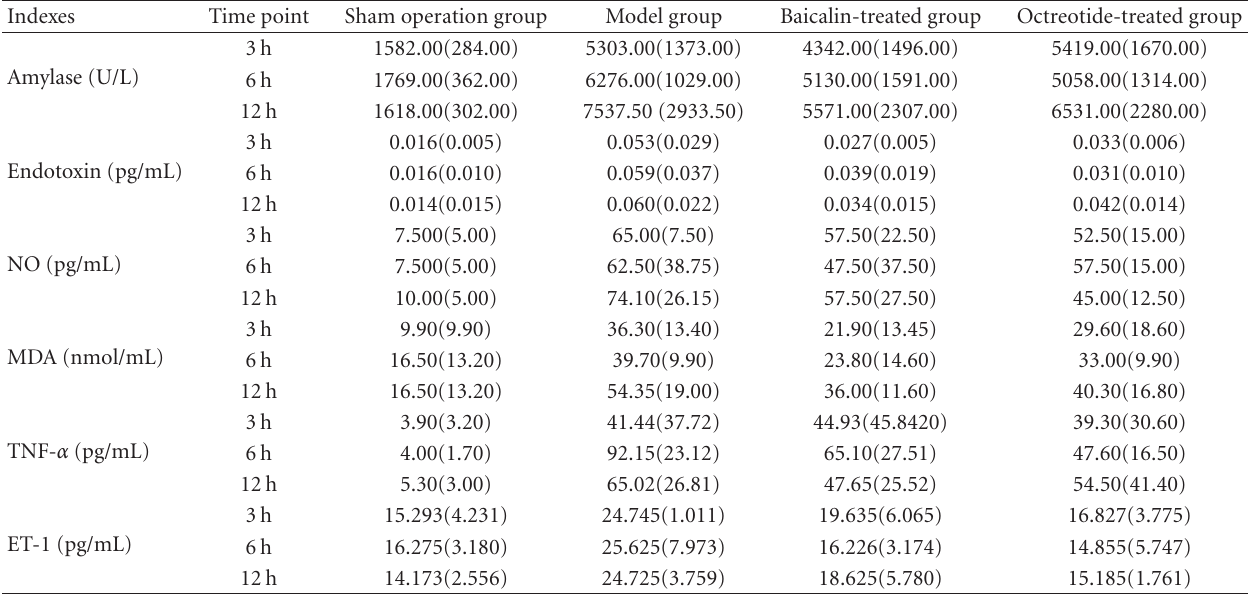
Table 1: Comparison of di ff erent indexes level in blood ( M ( Q R ))